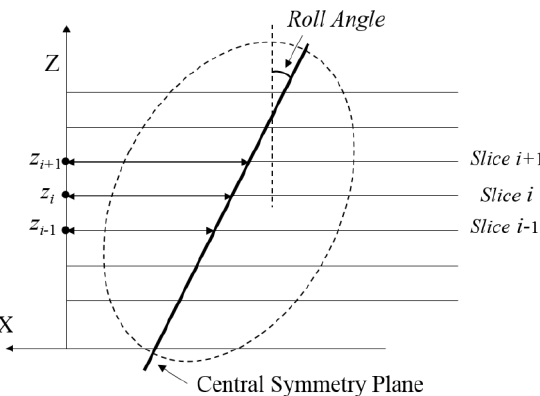
Figure 8. The relationship between the brain slice position ( Z r ) and the symmetric axis offset ( p r ). The illustration is adapted from [47] .